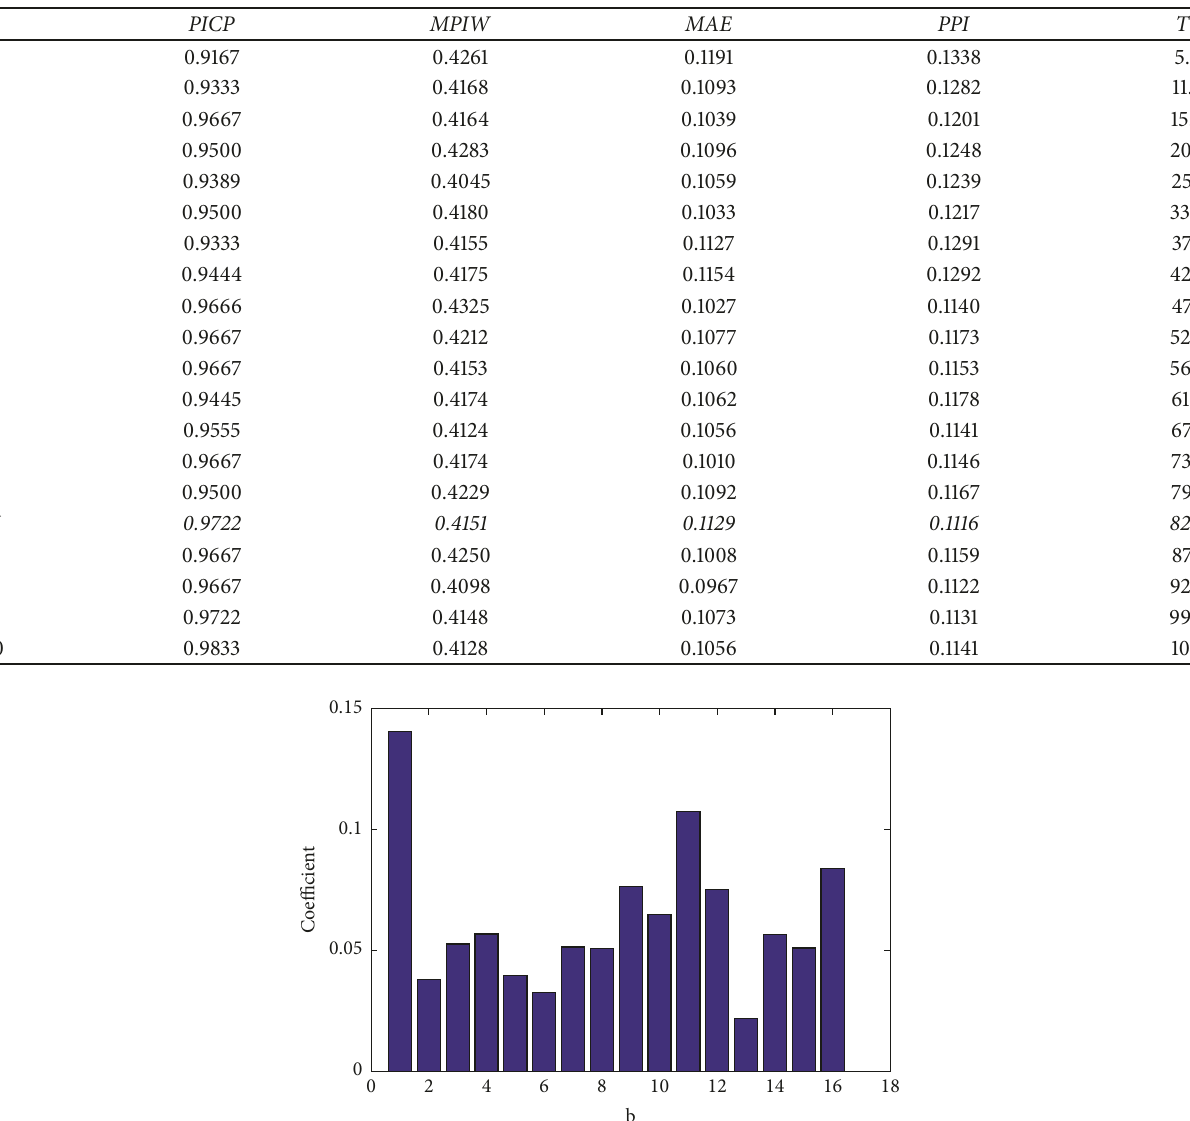
Figure 7: The histogram of the contribution coefficient of each local